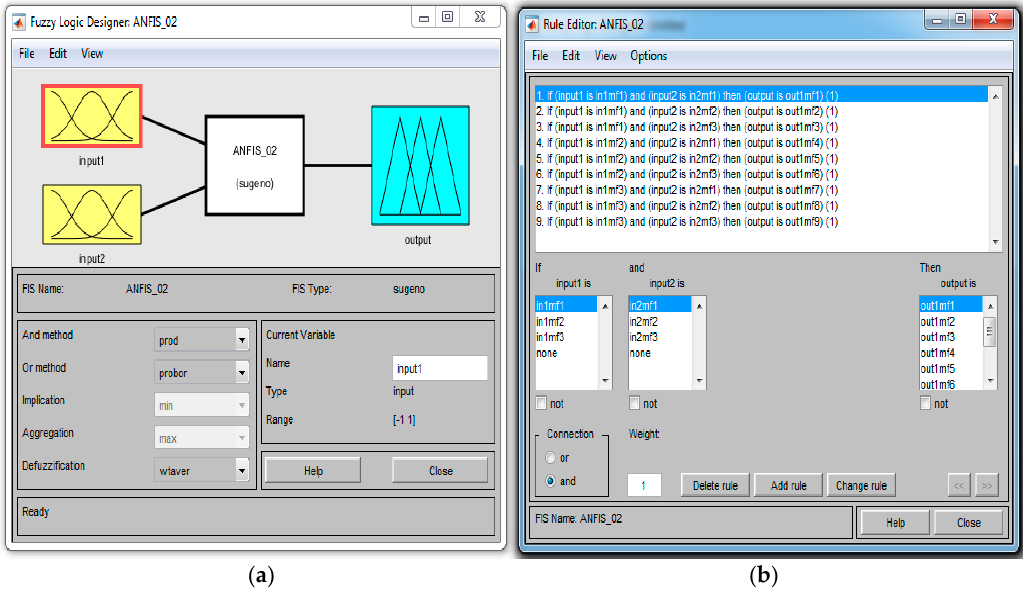
Figure 5. Simulation result: ( a ) FIS editor with two inputs and one output; ( b ) rule editor window.